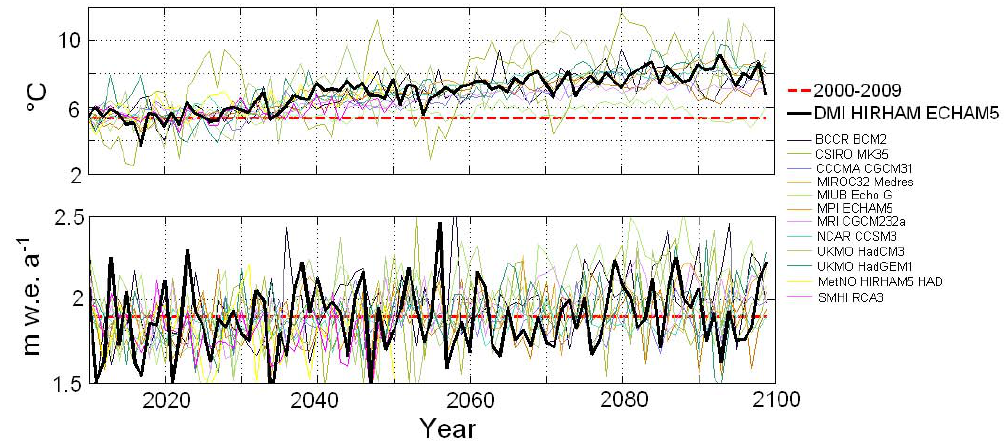
Fig. 9. Simulated mean annual temperature (upper panel) and precipitation (lower panel) development averaged over whole of Iceland; scenarios from the Nordic CES Project. The average climate of 2000–2009 is plotted for comparison (dashed line). The DMI HIRHAM ECHAM5 climate scenario is shown in bold because the results from this run are shown in bold in Fig. 11 and the modelled surface mass balance and glacier extent from this run are shown in Fig.